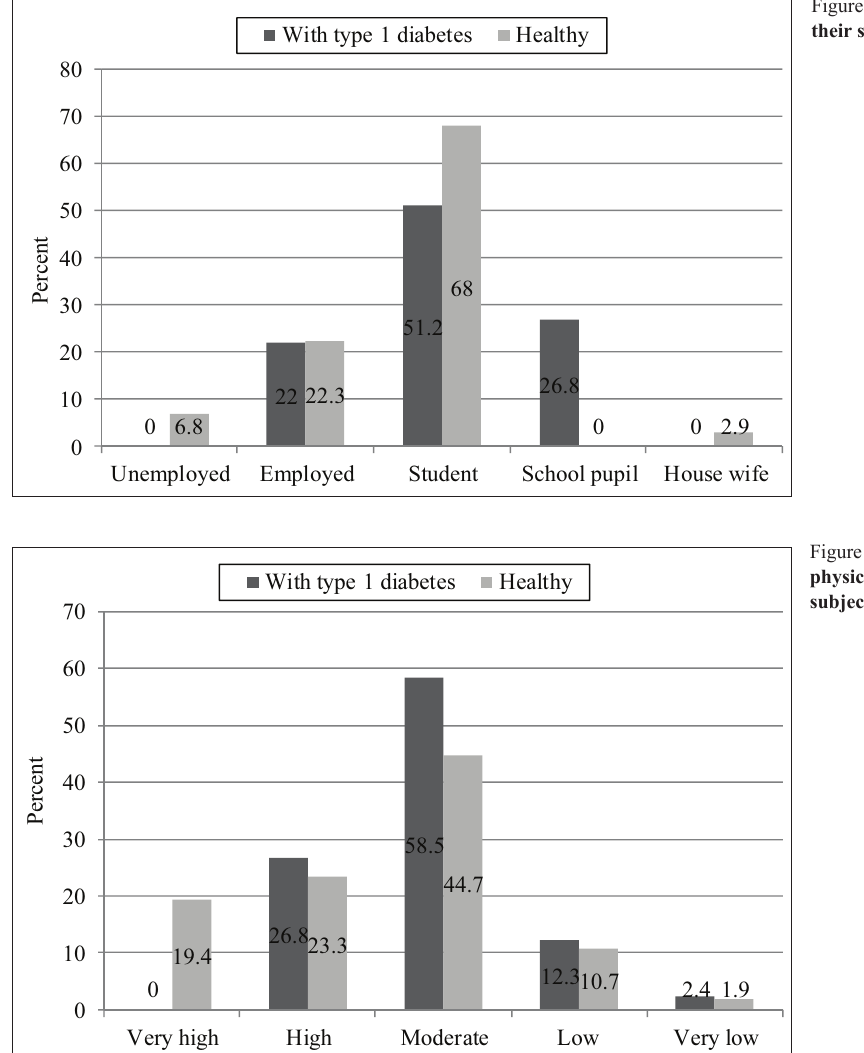
Figure 1. Distribution of respondents by their status